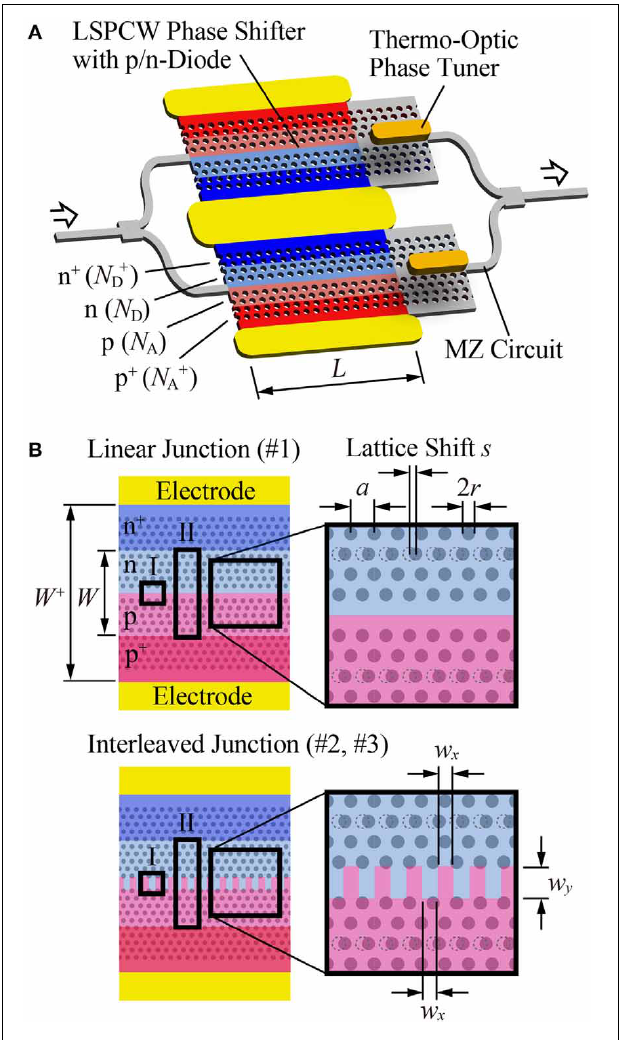
FIGURE 2 | Schematic of Si LSPCW MZ modulator. (A) Total view. (B) Two types of p/n junction. I and II correspond to models in Figures 3 , 4 ,